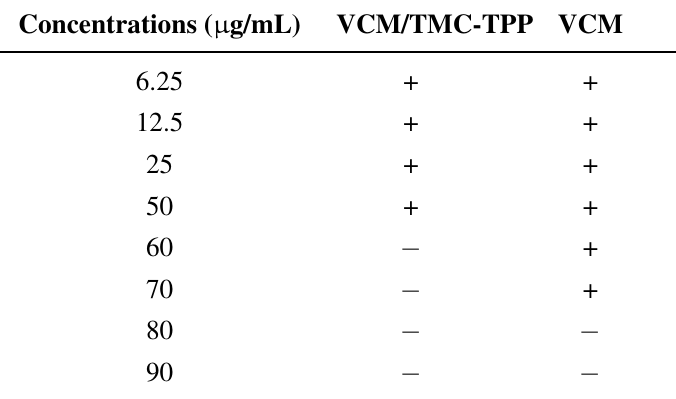
Minimum inhibitory concentration (MIC) test of various concentrations of vancomycin/ N -trimethyl chitosan (VCM/TMC) nanoparticle and VCM solution against S. aureus . “+” for bacterial growth, “ ´ ”for no bacterial